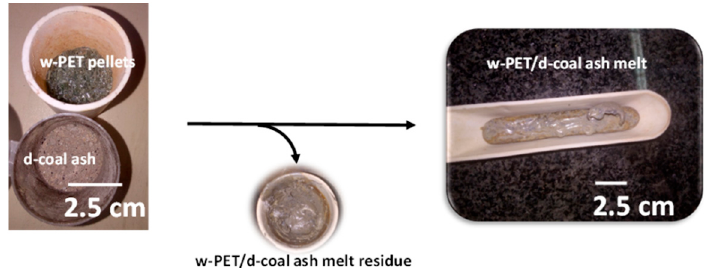
Figure 1. Photographs of w-PET pellets, d-coal ash powder, and w-PET/d-coal ash melt; also shown